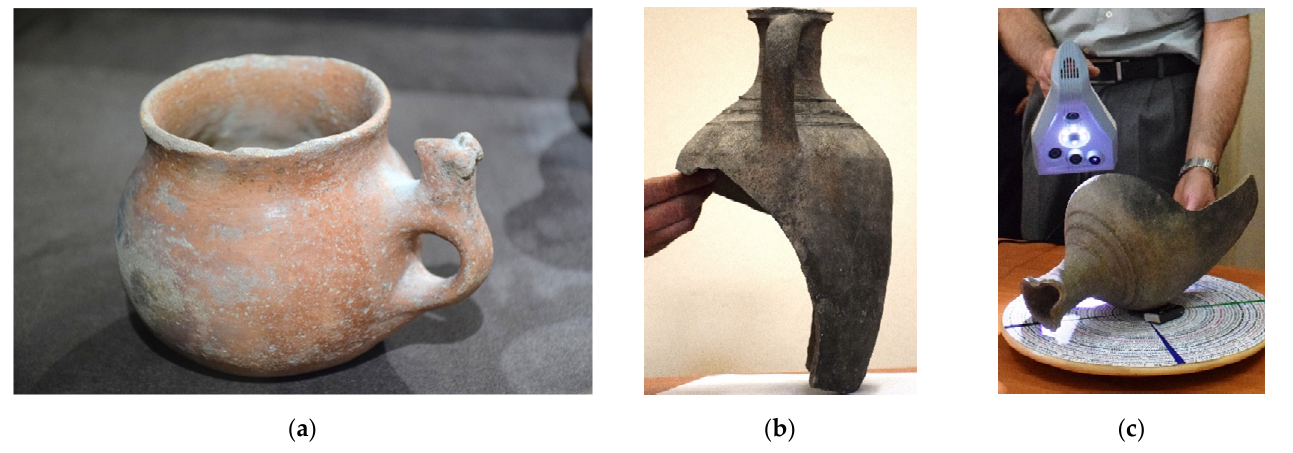
Figure 3. View of objects for digitisation: ( a ) mug; ( b ) jug; ( c ) work with the Artec Spider scanner.